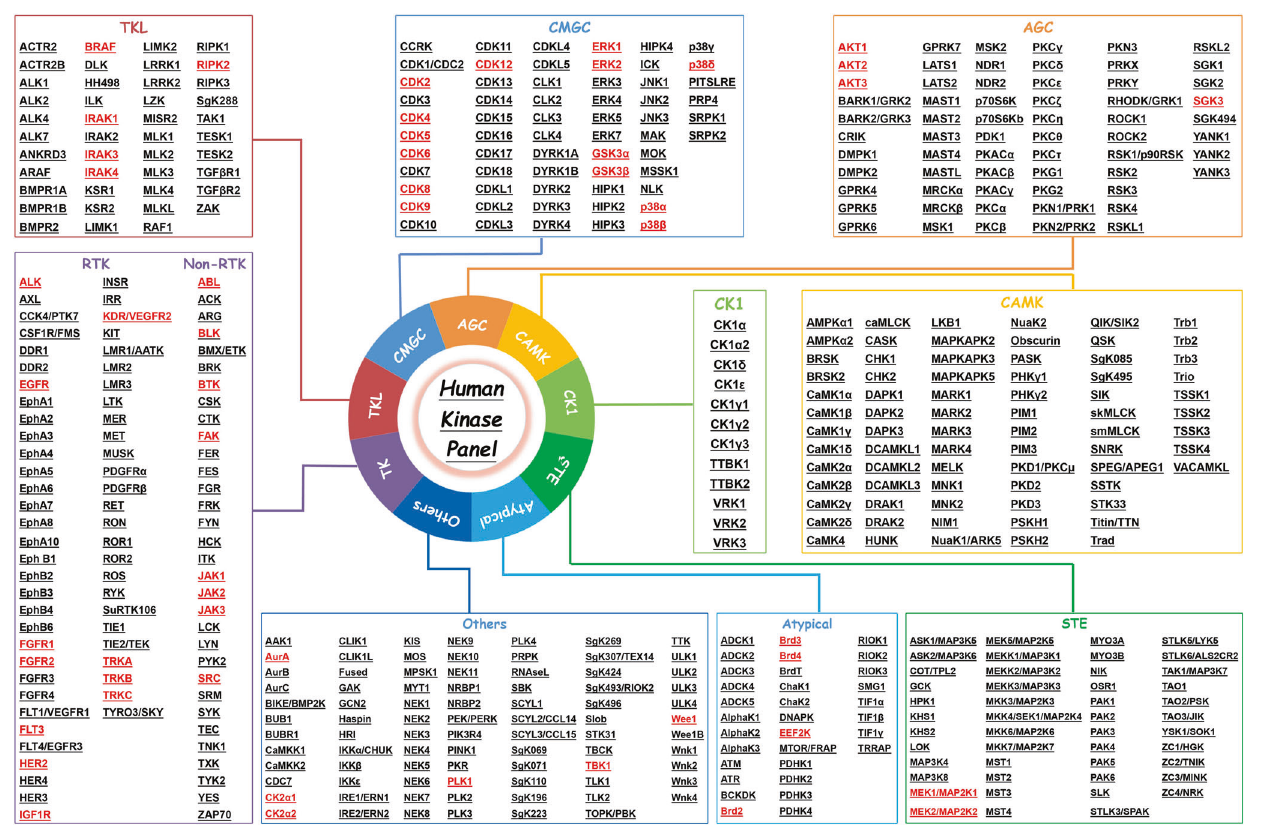
Fig. 3 The list of human “ degradable ” kinases based on